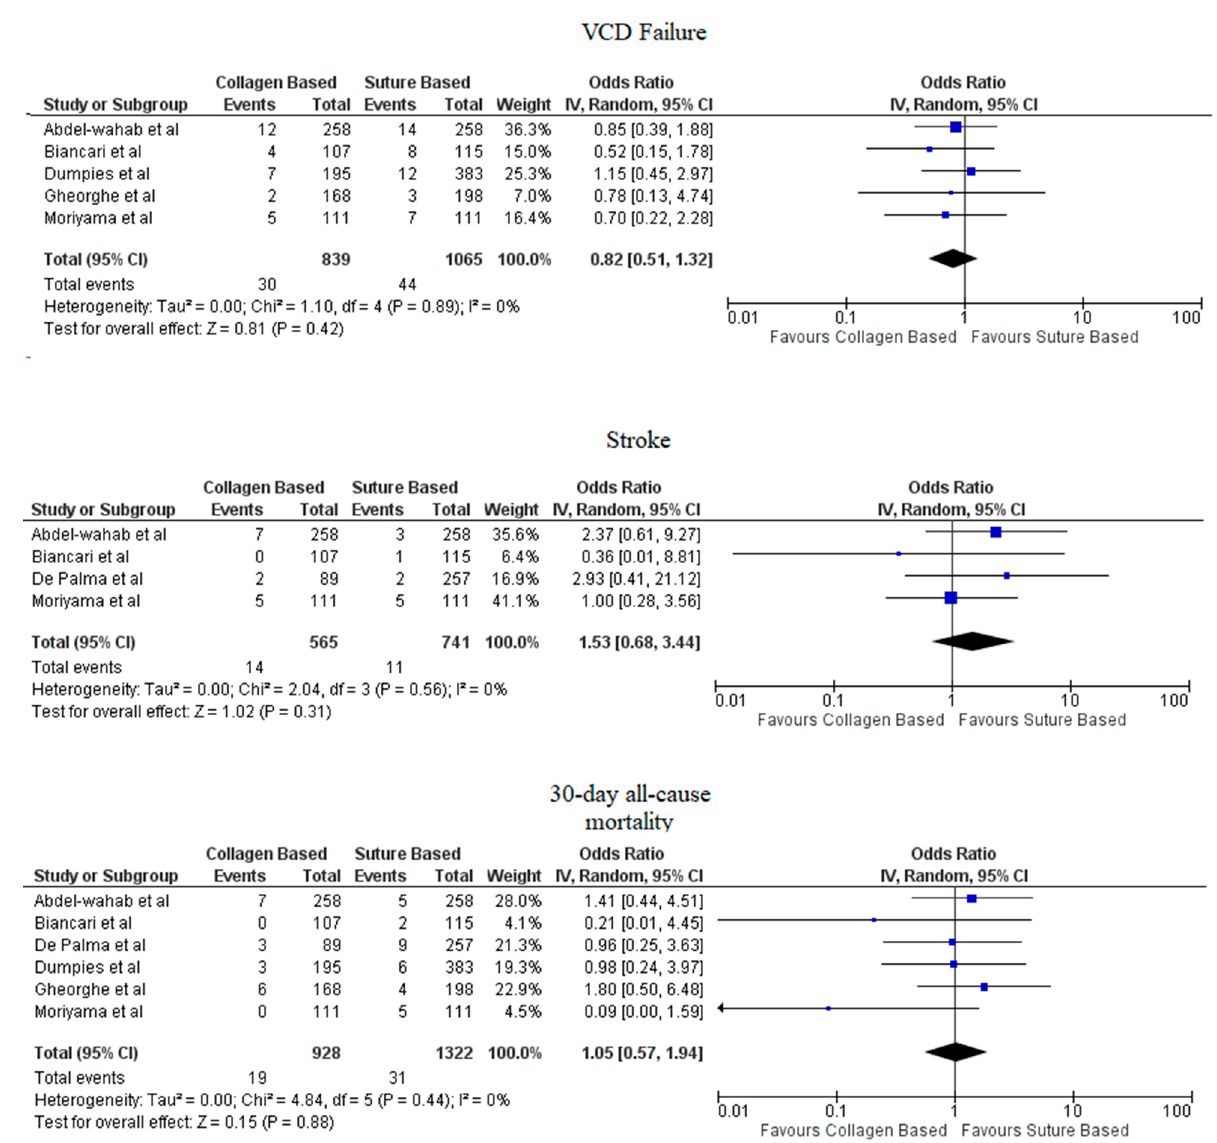
Figure 4. Forest plot of procedural and post-procedural complications of collagen-based vs. suture vascular closure device for large bore arteriotomies. CI: Confidence interval, IV: Instrumental variable, VCD: Vascular closure device.